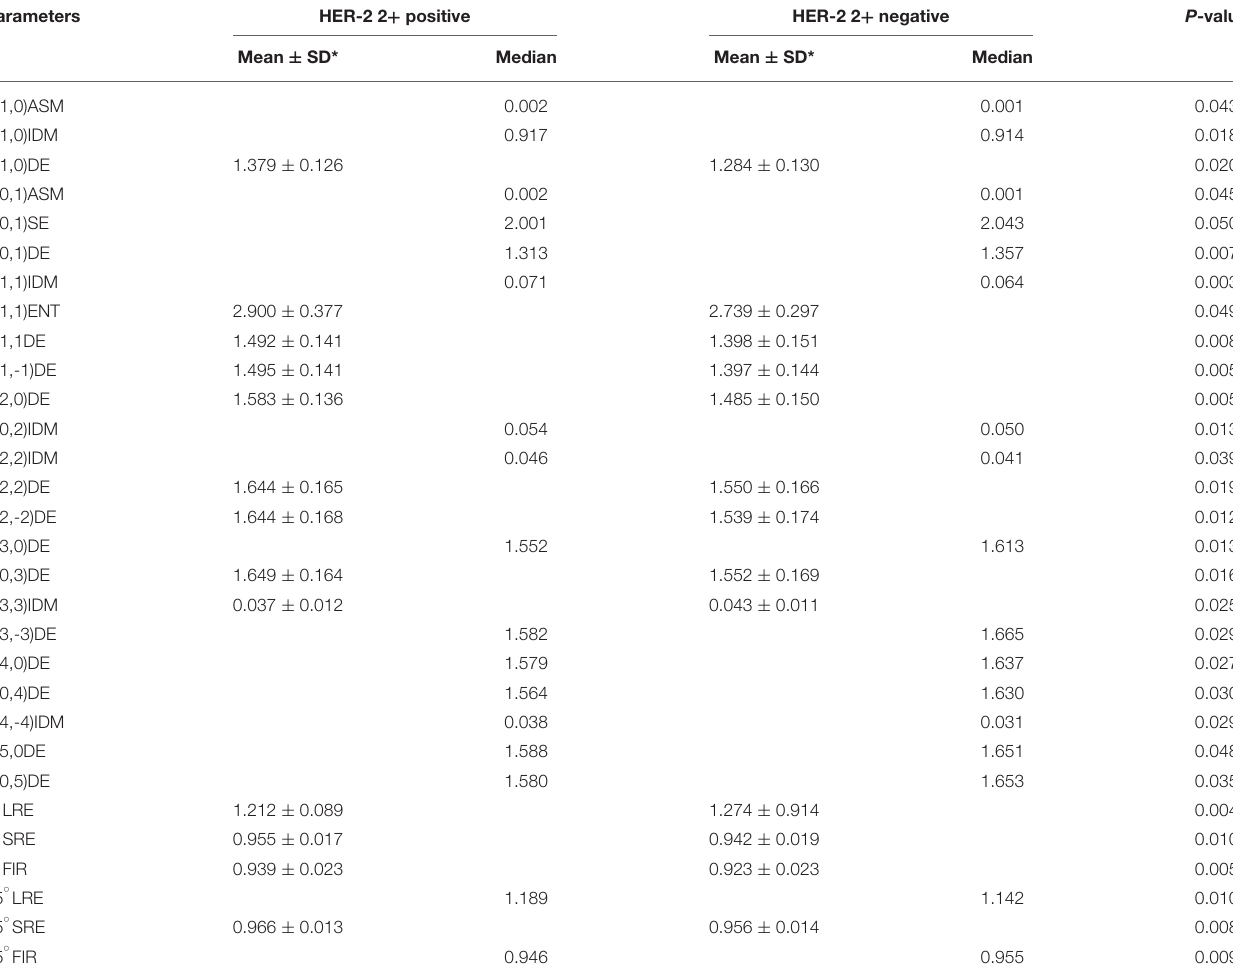
TABLE 3 | Features with statistically significant differences as measured by a Student’s t -test or Mann-Whitney U -test. Parameters